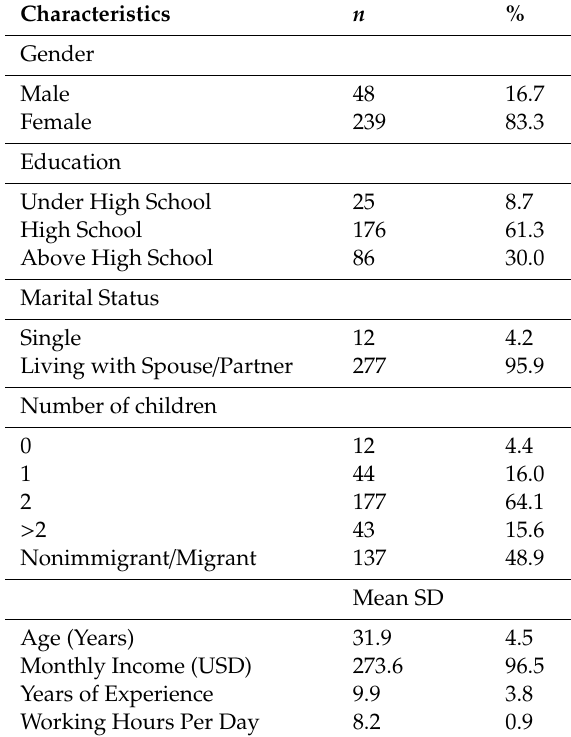
Table 1. Demographic and working characteristics of